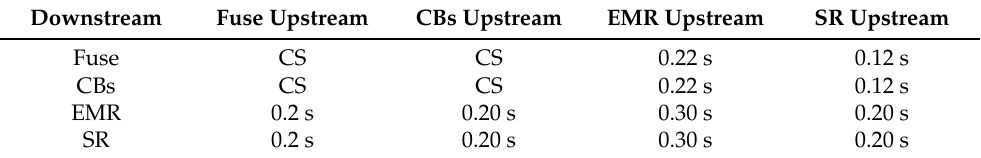
Table 2. Minimum CTIs